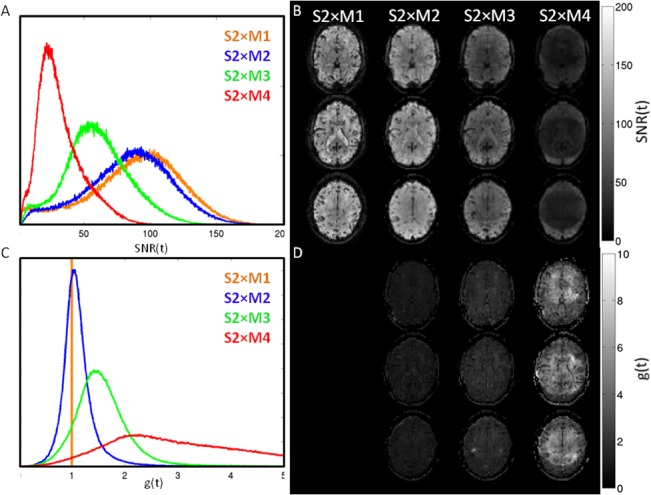
Histograms of temporal SNR(t) (A) and apparent g-factor gapp(t) (C) as well as selected slices of temporal SNR(t) (B) and apparent g-factor maps (D) for different M-factors of one subject.The histograms were obtained by averaging the respective whole brain histograms of all 20 subjects for different M-factors.